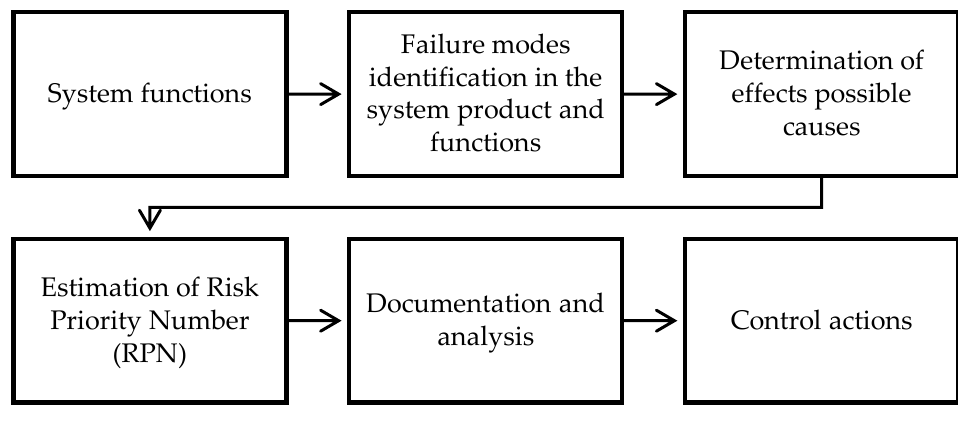
Figure 1. Phases of FMEA [31] .